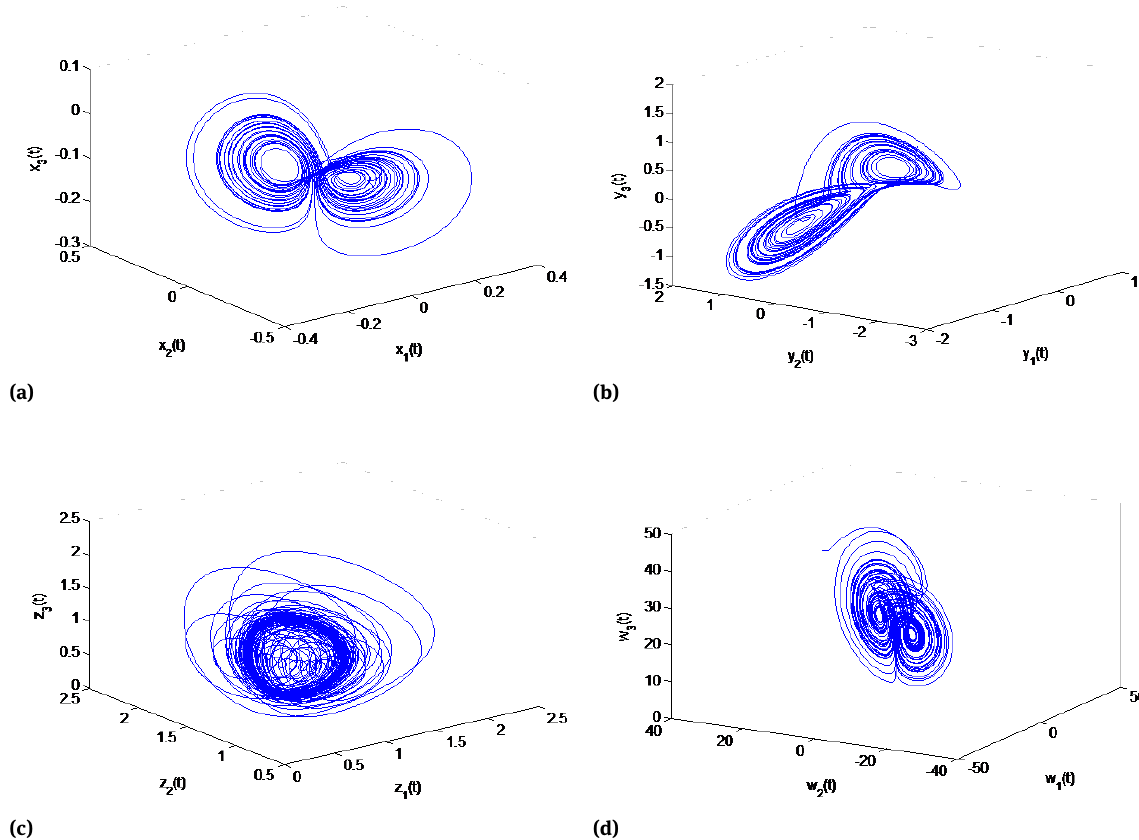
Fig. 1: Phase portraits of fractional order (a) Newton-Leipnik system, (b) Liu system, (c) Lotka-Voltra system, (d) Chen system for the order of derivative q =